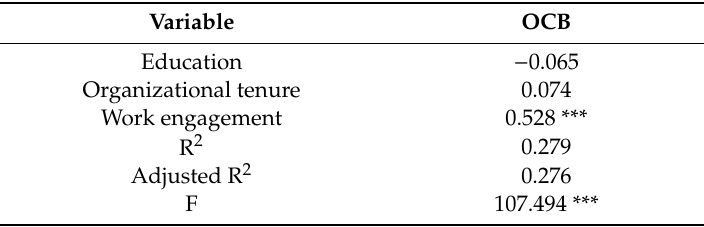
Table 4. Regression analysis results of work engagement and